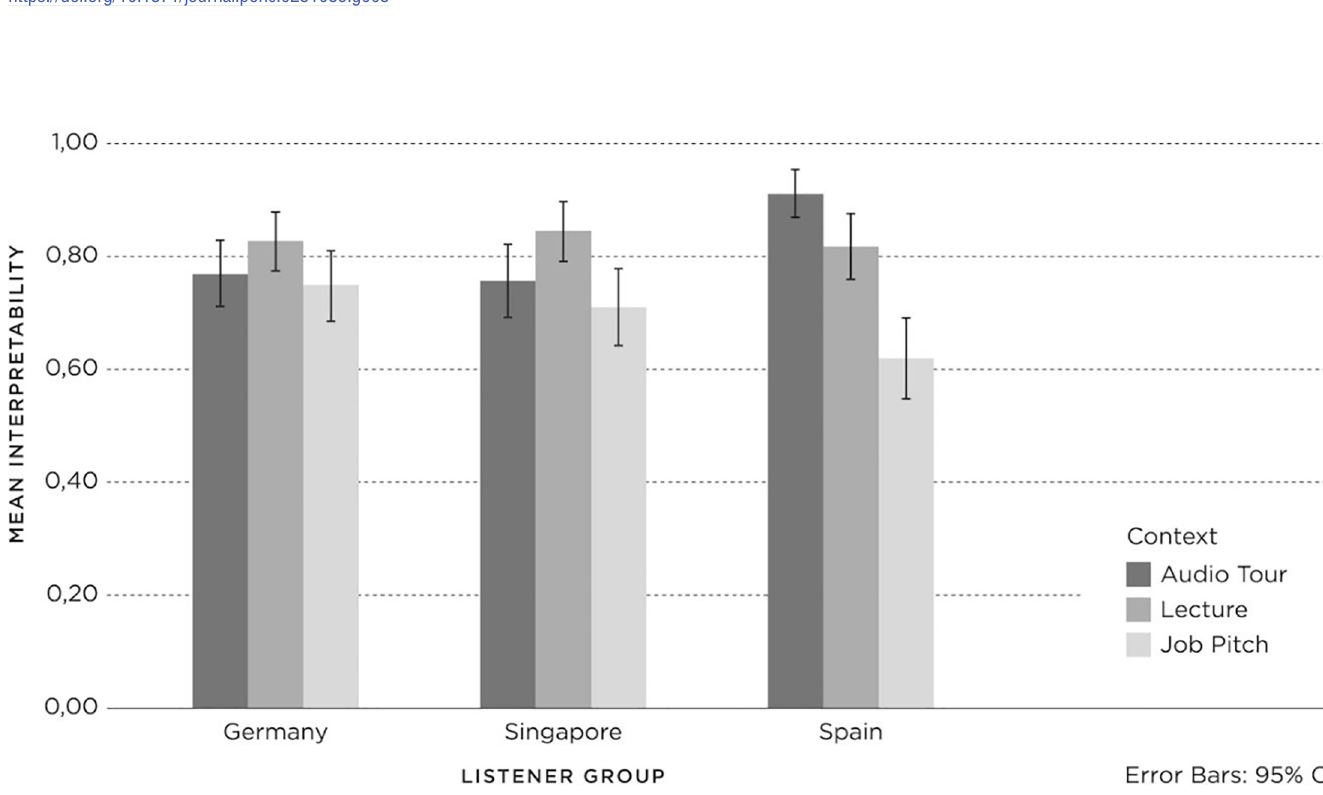
Fig 4. Mean proportions of correct interpretability for context (Audio Tour, Lecture, Job Pitch) and listener group (Germany, Singapore, Spain).